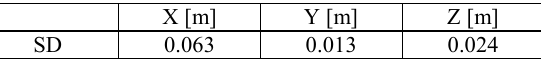
Table 5. Achieved standard deviations of terrestrial images